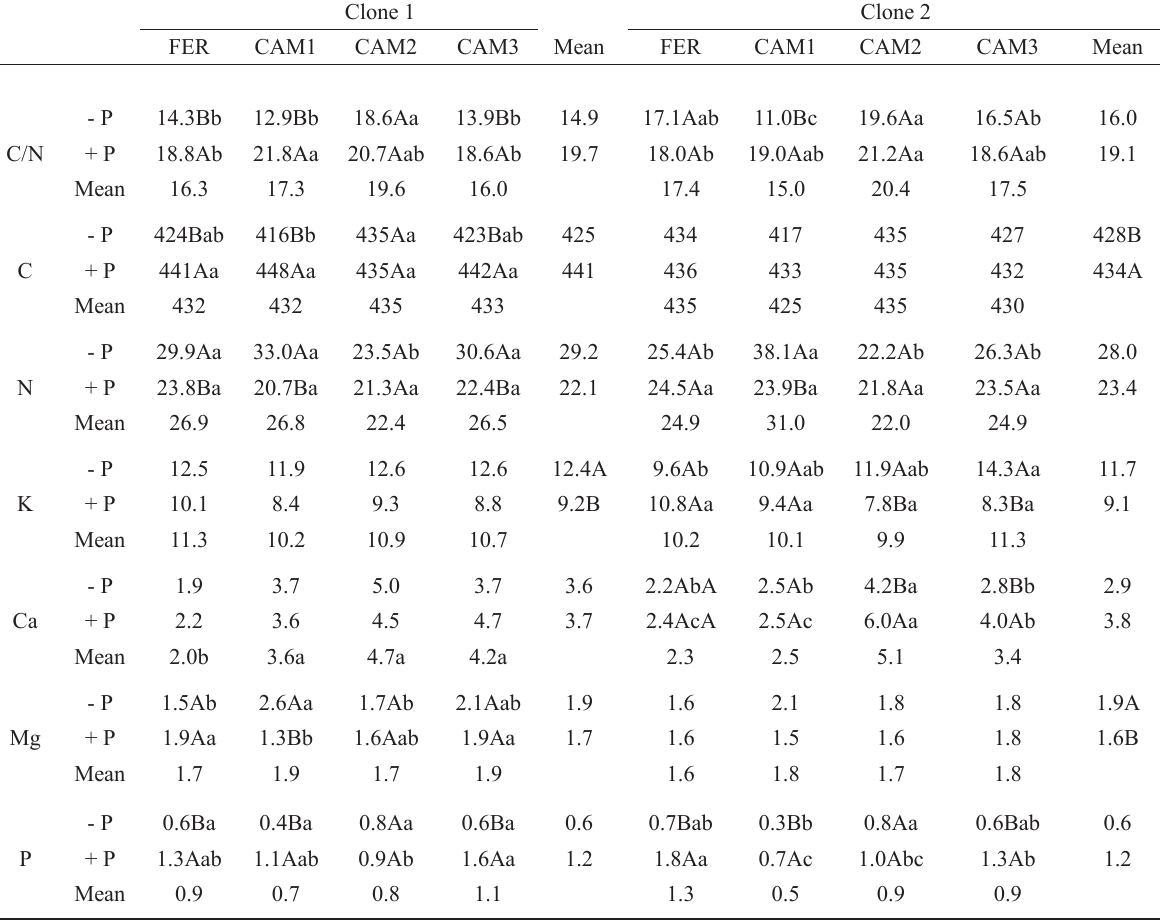
Carbon/nitrogen ratio (C/N) and C, N, K, Ca, Mg and P contents (g kg -1 ) in leaves of yerba mate clones in response to P fertilization, at 210 days after installation of the experiments 1